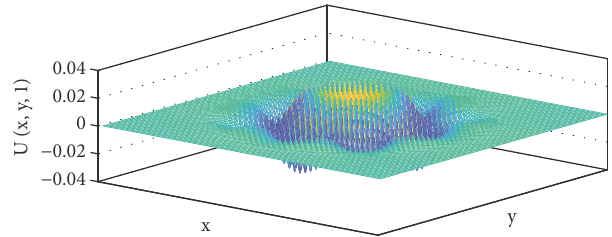
Figure 4: Numerical solution for two space dimension in an unbounded domain when the positivity and stability condition is broken, for 𝑡 = 𝑇 = 1 .